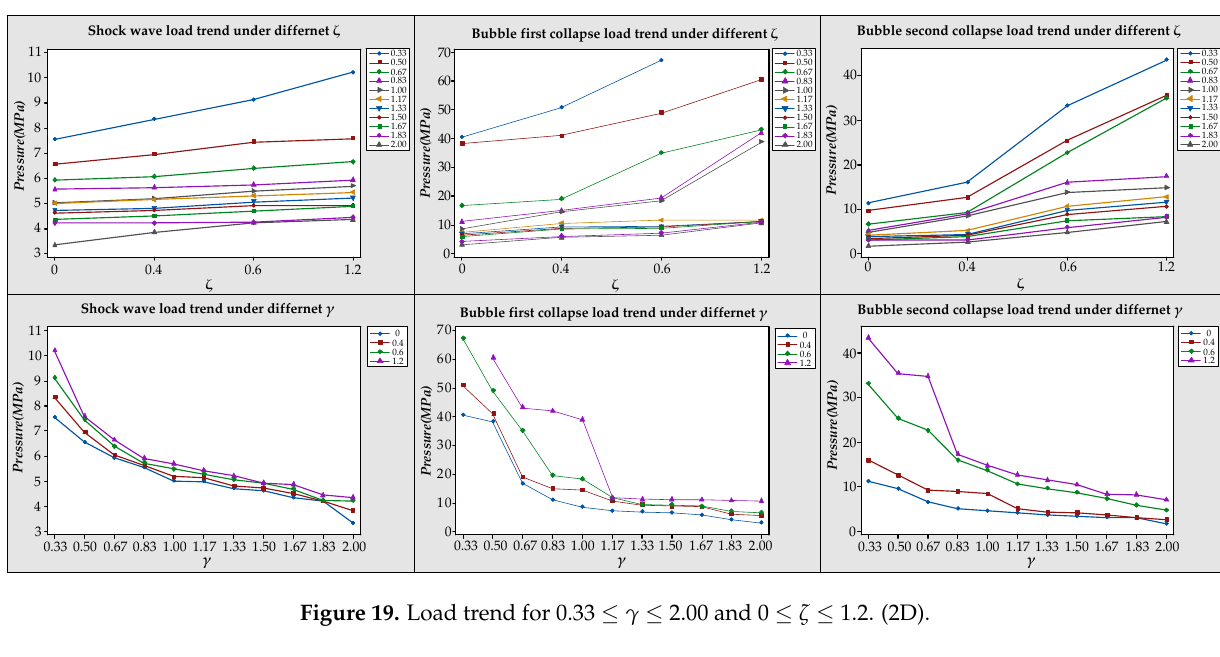
Figure 19. Load trend for 0.33 ≤ γ ≤ 2.00 and 0 ≤ ζ ≤ 1.2. (2D).